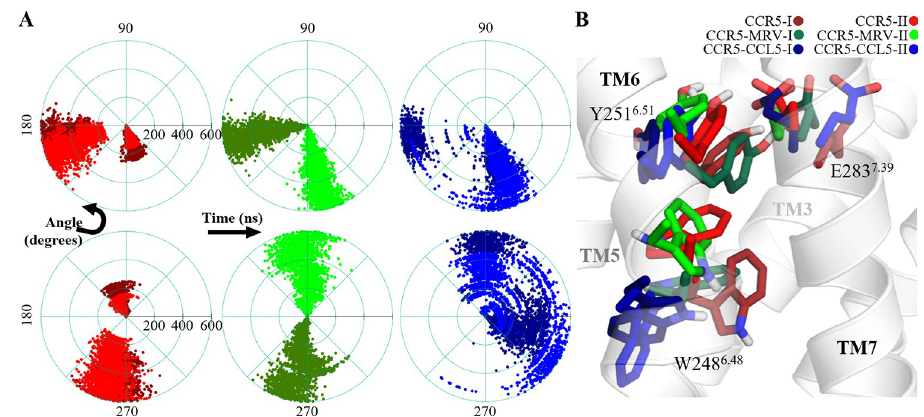
Fig 4. The link between the orthosteric site and the transmission switch. (A) Angular plots of the rotamers of W248 6.48 , and (B) superposed configurations and the pair Y251 6.51 -E283 7.39 , where W248 6.48 is oriented towards TM5 only in the chemokine complex. The angular plots are for χ 1 (top) and χ 2 (bottom) dihedrals of W248 6.48